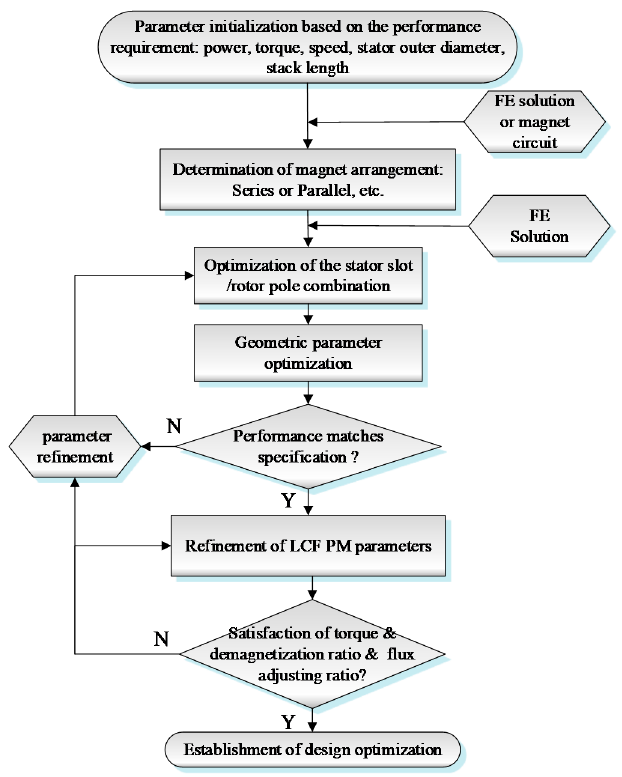
Figure 10. The overall design flowchart of the PS-SF-HMMM.